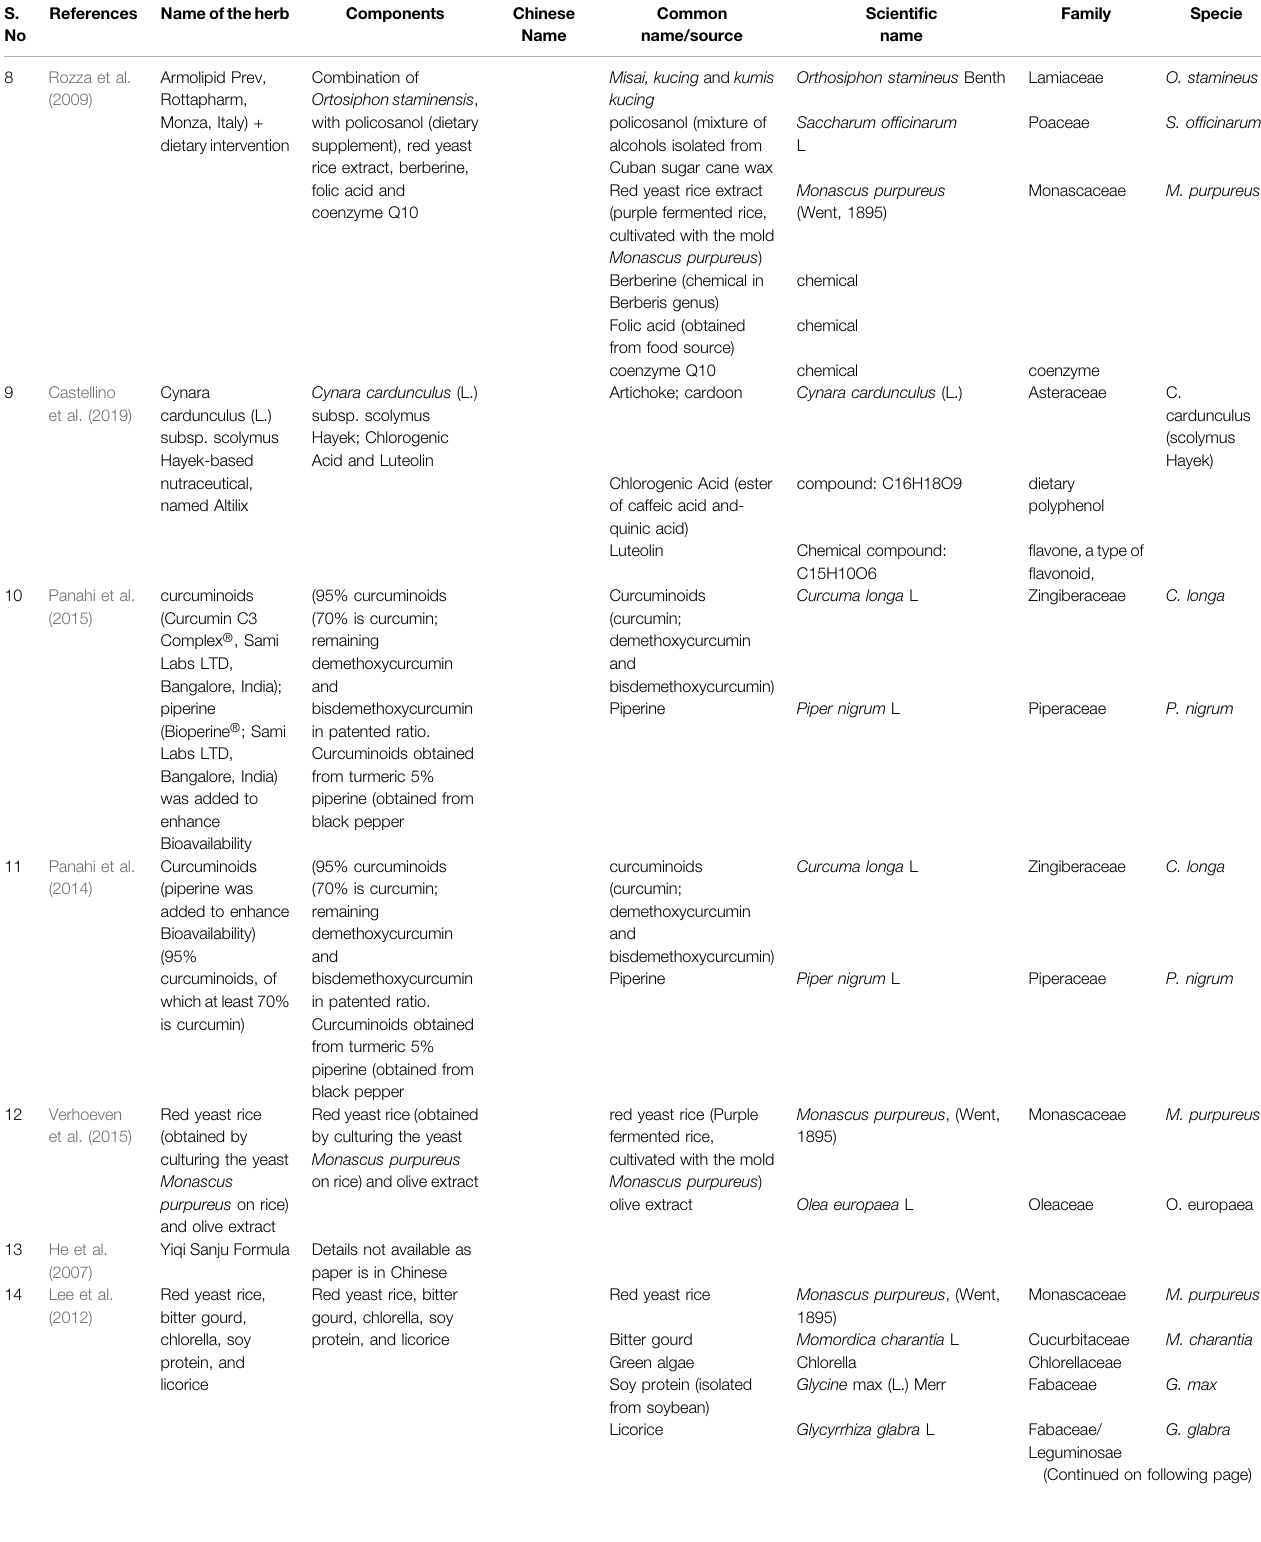
TABLE 2 | ( Continued ) Taxonomic classi fi cation of all the polyherbal combinations used in clinical studies against metabolic